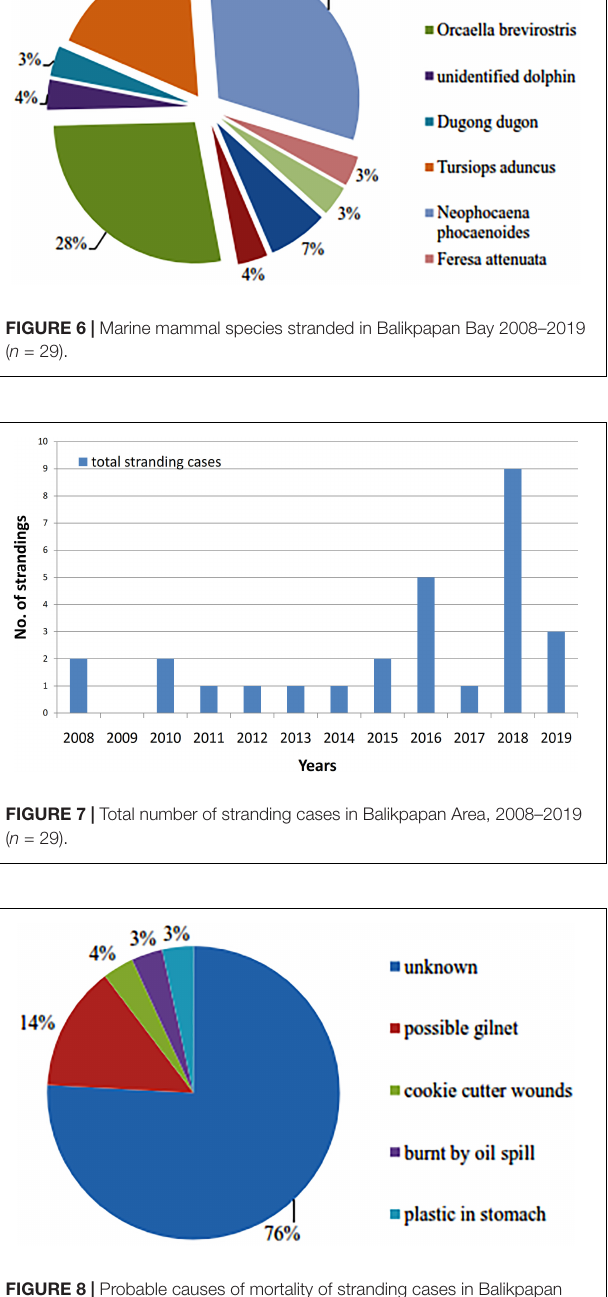
of 0.5, mean annual mortality is also higher than respective PBR values of 0.27 and 0.45 for N min and N best for recovery rates of 0.5 from density sampling and N min for mark- recapture estimate (PBR = 0.55). However mean annual mortality is lower than the PBR value obtained from N